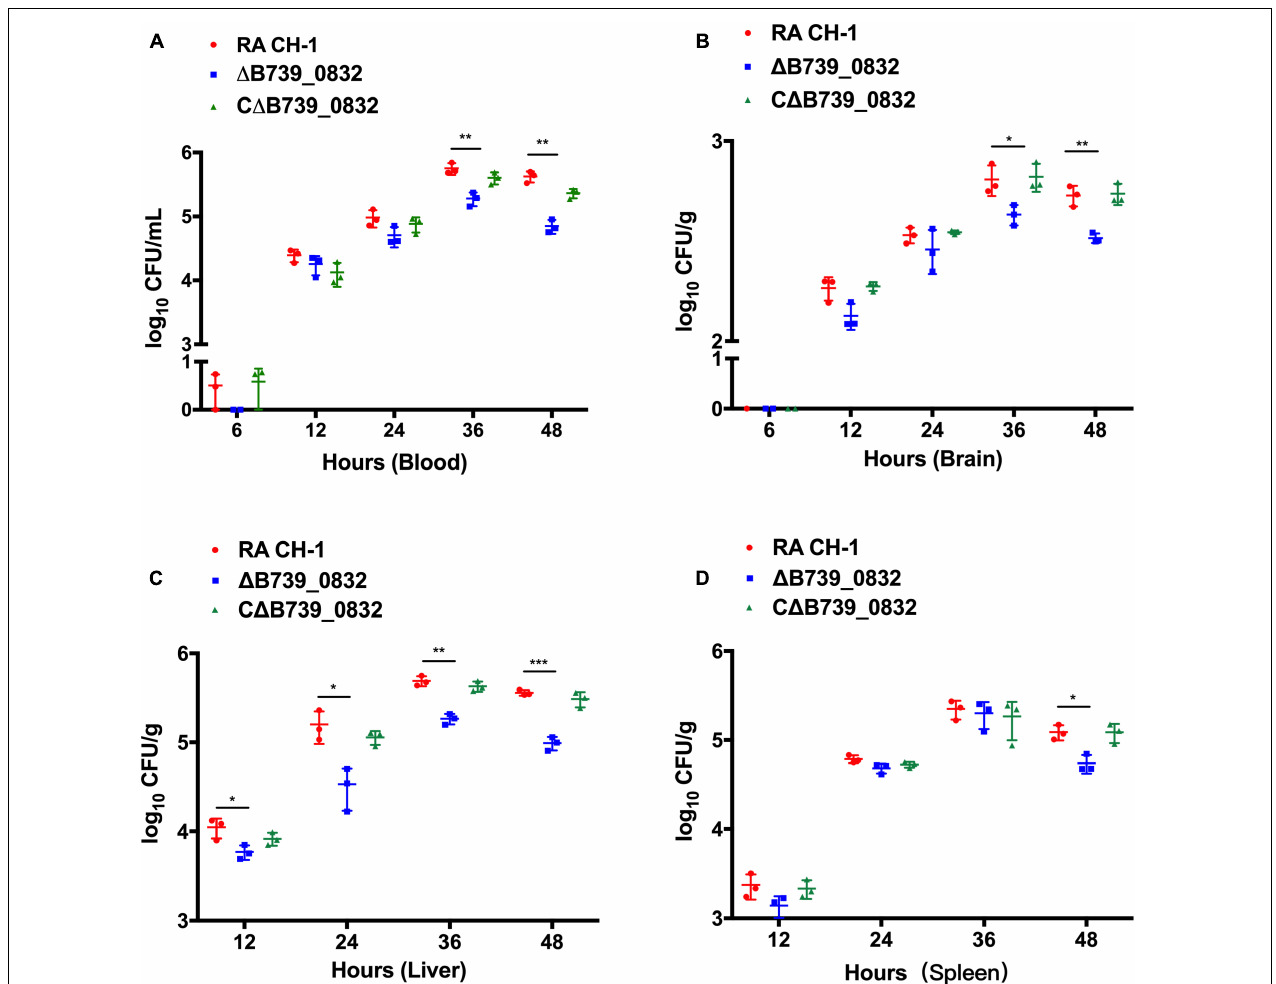
FIGURE 5 | Bacterial loads in blood (A) , brain (B) , liver (C) , and spleen (D) of ducks infected with R. anatipestifer CH-1, (cid:49) B739_0832 , or C (cid:49) B739_0832 strains at 6, 12, 24, 36, and 48 h post-infection. Error bars represent standard deviations from three independent experiments (*** p < 0.001, ** p < 0.01, and * p <